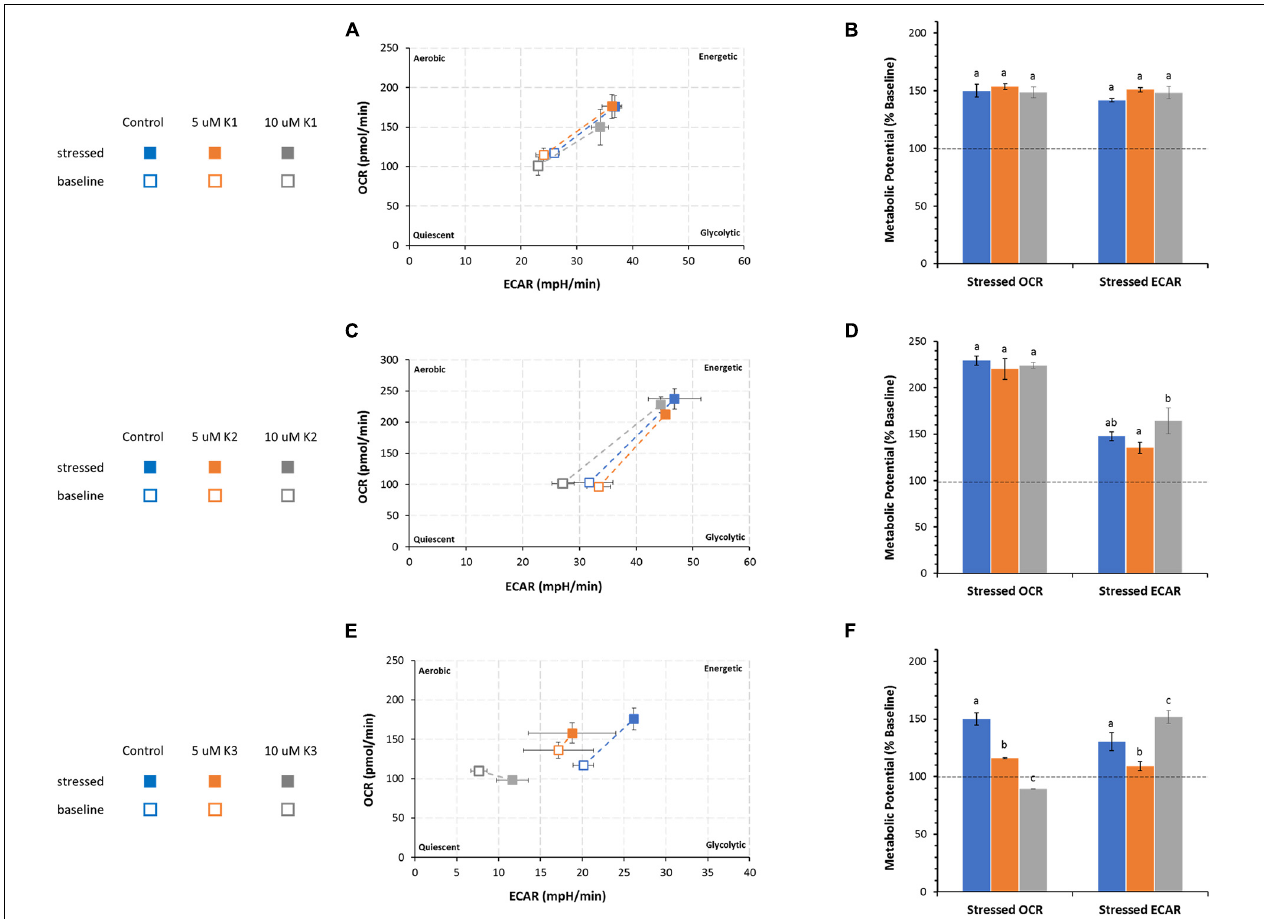
FIGURE 5 | Effect of VKs on the energy map of IPEC-J2 cells. Baseline (empty squares) and stressed (full squares) phenotypes of IPEC-J2 cells in VK absence (control, blue squares) and in the presence of 5 µ M, orange squares) or 10 µ M (gray squares) VK1 (A) , VK2 (C) , and VK3 (E) . The Metabolic potential in “Stressed OCR” and “Stressed ECAR” is expressed as % “Baseline OCR” and “Baseline ECAR” (dashed horizontal line), in VK absence (blue) ( (cid:4) ) or in the presence of 5 µ M (orange) ( (cid:4) ), or 10 µ M (gray) ( (cid:4) ) VK1 (B) , VK2 (D) , and VK3 (F) . Data expressed as points (A,C,E) and column chart (B,D,F) represent the mean ± SD (vertical and where present also horizontal bars) from three experiments carried out on distinct cell preparations. Different letters indicate significant differences ( P ≤ 0 . 05 ) among treatments within the same